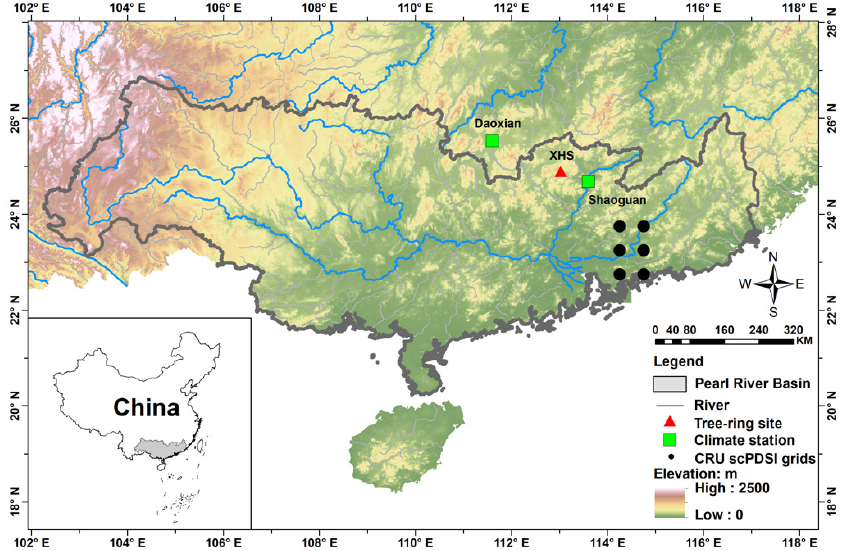
Figure 1. Map of the Pearl River basin showing the location of the tree ring sampling site (red triangle), nearby meteorological stations (green square), and the Climatic Research Unit (CRU) self-calibrating Palmer drought severity index (scPDSI) grids (black circle).